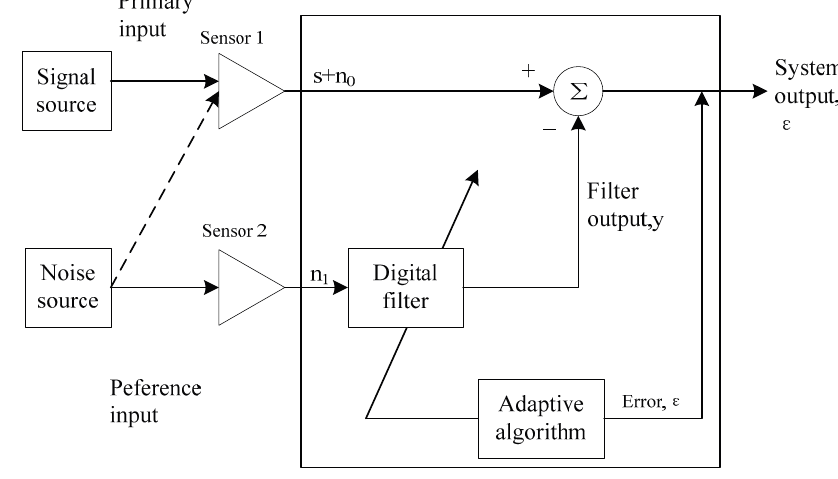
Figure 5. Block diagram of an adaptive noise